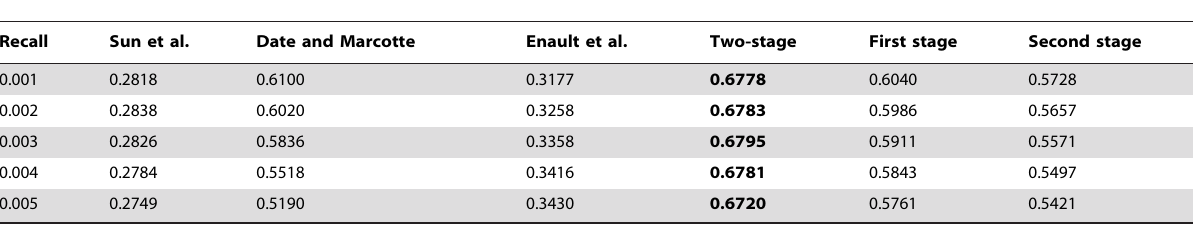
Table 3. Adjusted area under curve (AUC) comparison at specific recalls.